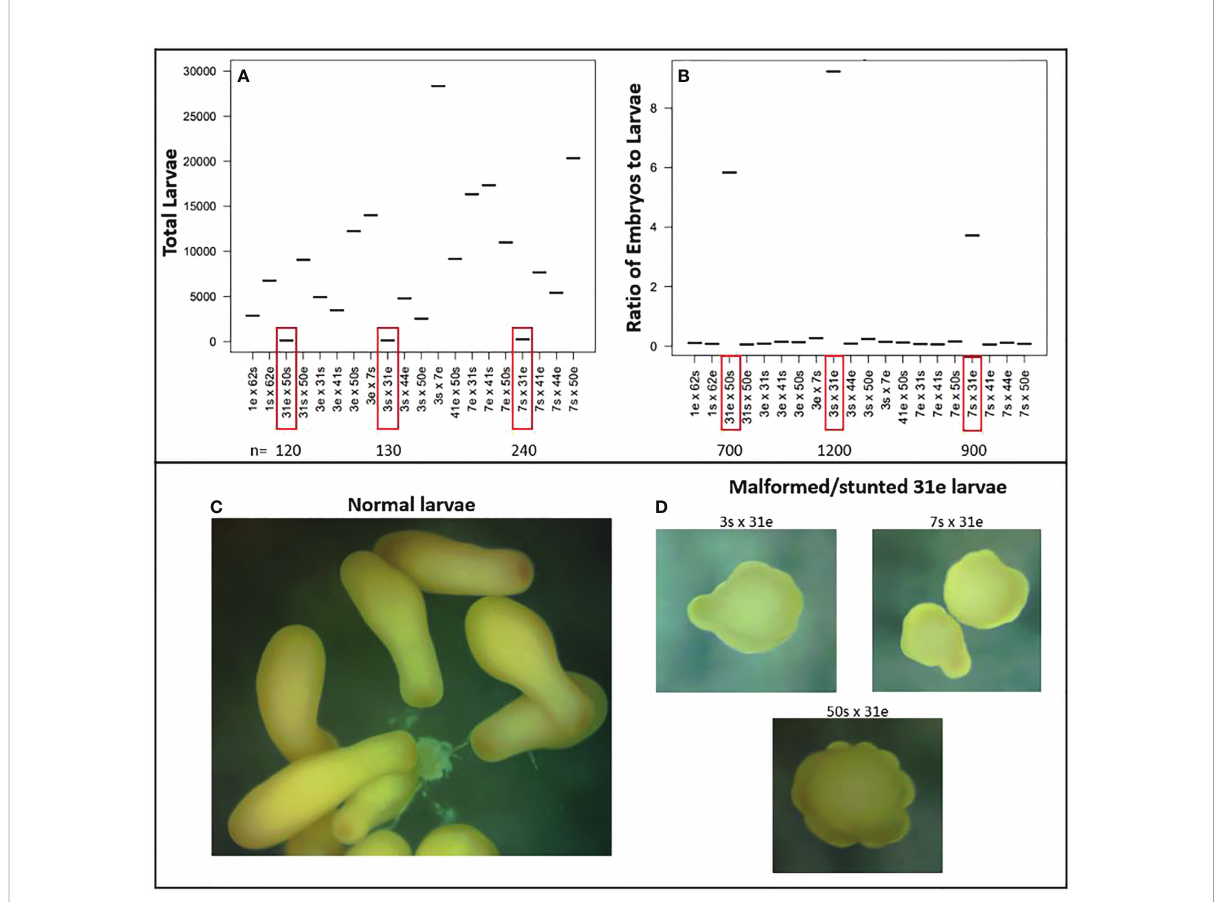
FIGURE 10 Unsuccessful crosses with genet 31 as the dam (egg donor). (A) Total number of larvae produced for each cross. Crosses with 31e had high larval mortality and low fi nal yield. (B) Ratio of enumerated fertilized eggs to total larvae produced for each cross. Crosses with 31e had anywhere from 4-9x more embryos than larvae, again indicating high larval mortality. (C) The typical bowling pin shape of a competent planula larva. (D) Abnormal morphology observed for subsamples of larvae from crosses with